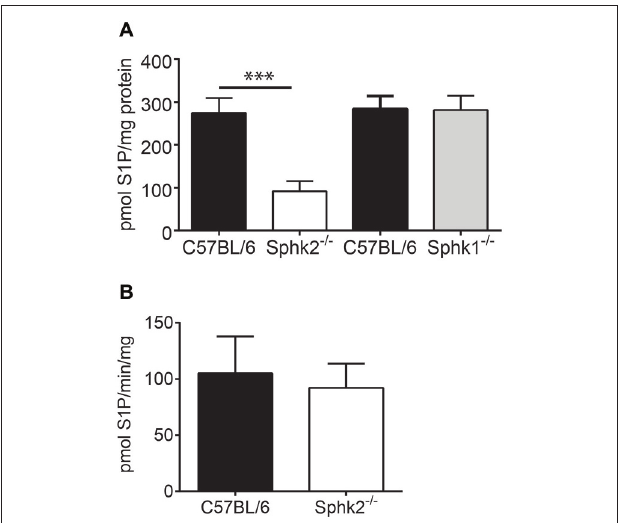
FIGURE 2 | Sphingosine kinase activity and sphingosine 1-phosphate (S1P) levels in mouse SC. (A) Assessment of the amount of spinal S1P in C57BL/6 and Sphk-deficient mice. Whereas the amount of S1P was substantially reduced in SCs from Sphk2 − / − mice in comparison to C57BL/6 it was virtually unchanged in Sphk1 − / − mice ( n = 5, one-way ANOVA, Bonferroni’s post hoc test, ∗∗∗ p < 0.001). (B) The Sphk1 activity was not different between SCs of C57BL/6 and Sphk2 − / − mice ( n = 5, paired t -test).